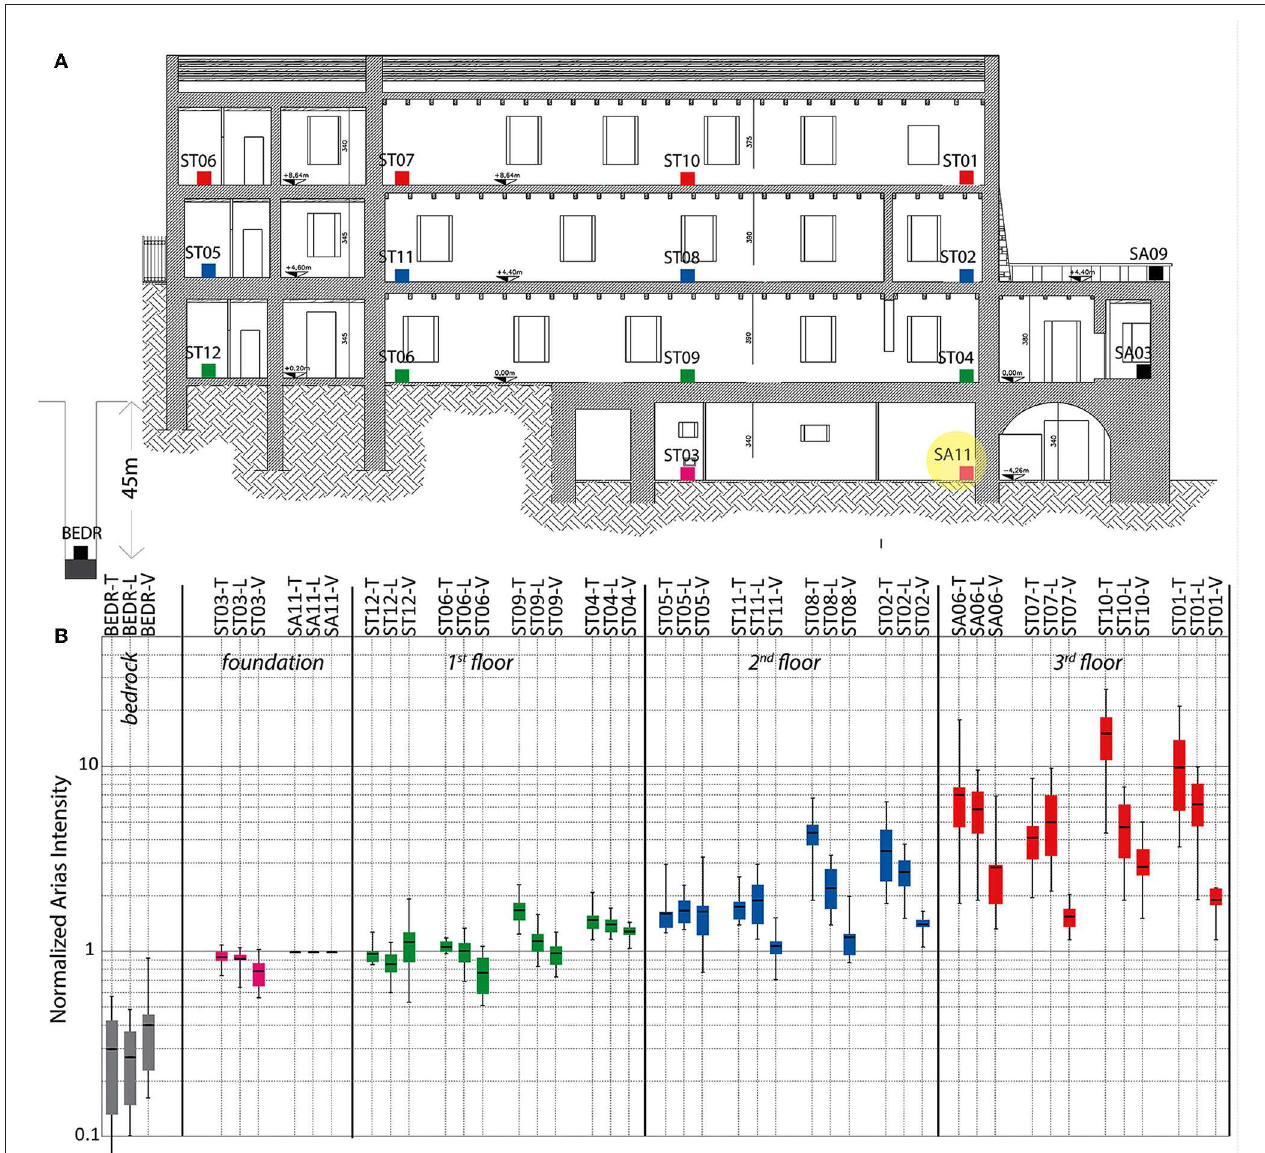
FIGURE 9 | Arias intensities at the sites normalized respect to that at the base (SA11). The Arias intensities were obtained by acceleration time histories filtered with acausal bandpass Butterworth filter of 4th order in the band 0.1–10Hz. (A) The colored square represents the location of the seismic stations for each floor reported on the section of the wall. (B) The colored box represents the confidence (between 25th and 75th percentile) and the thick black line is the median, whereas the thin black lines are the range between maximum and minimum. The normalized Arias intensities are reported for each site and component (T, transverse; L, longitudinal; V,